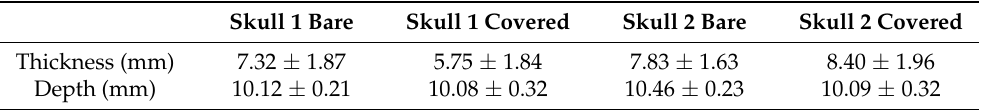
Table 1. Reference skull bone dimensions used in setting the depth and thickness of the 3D printed surrogate bone sections, obtained from